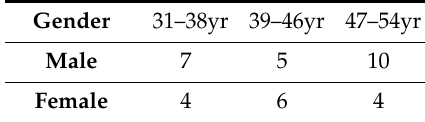
Table 2. Description of the age of the participants